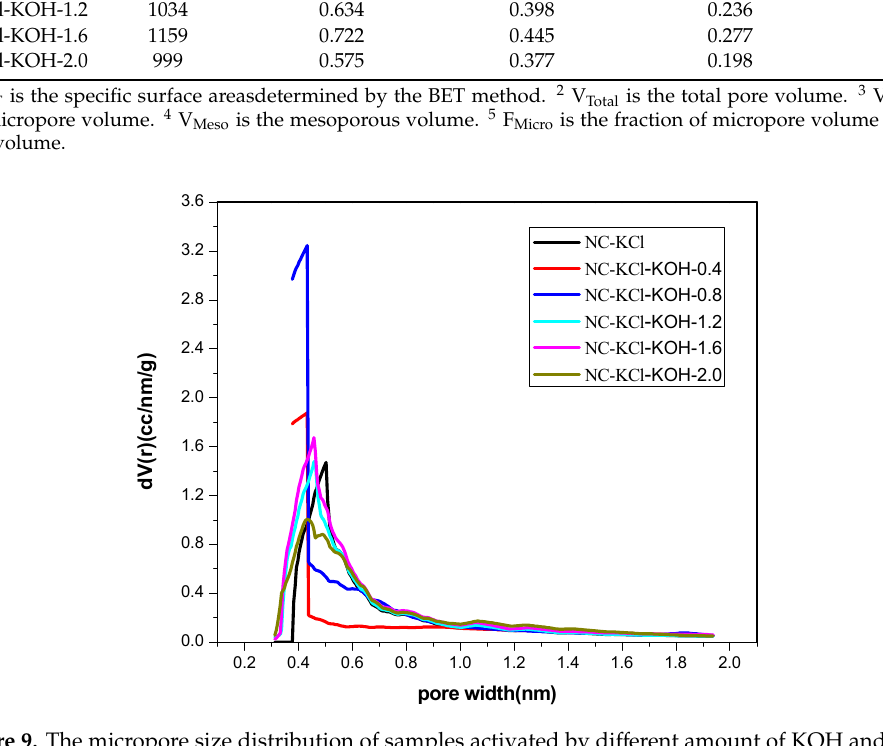
Figure 10. X-ray diffraction patterns of typical samples.